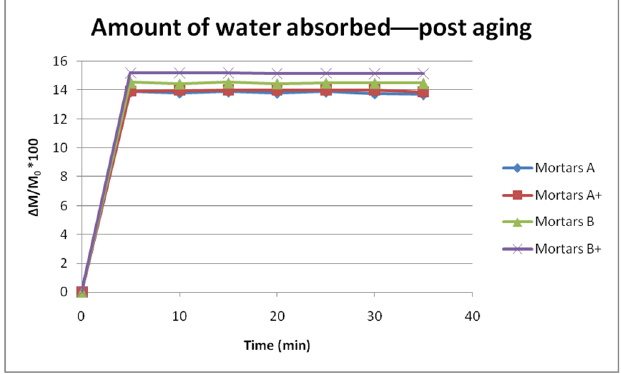
Figure 2. Water absorbed for the designed mortars after aging.